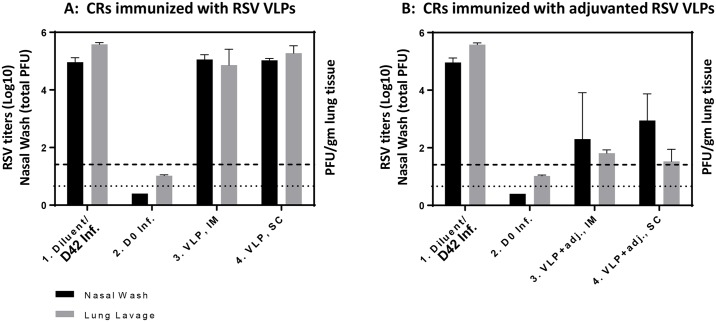
CRs immunized with adjuvanted RSV VLPs protected the lower as well as the upper respiratory tract.
A: Vaccination with RSV VLPs provided virtually no protection in the lung or nose of CRs: There was a statistically significant, but not a meaningful reduction in the virus load in the lung (Gp1 vs Gp3, P<0.019; Gp1 vs Gp4, P<0.029) and no virus reduction in nasal wash samples (P>0.05). B: Adjuvanted RSV VLPs conferred protection based on substantial virus clearance from the lung (Gp1 vs Gp3 and Gp4, P<0.00001) as well the nose of these animals (Gp1 vs Gp3
P<0.0073; Gp1 vs Gp4. P<0.0013).